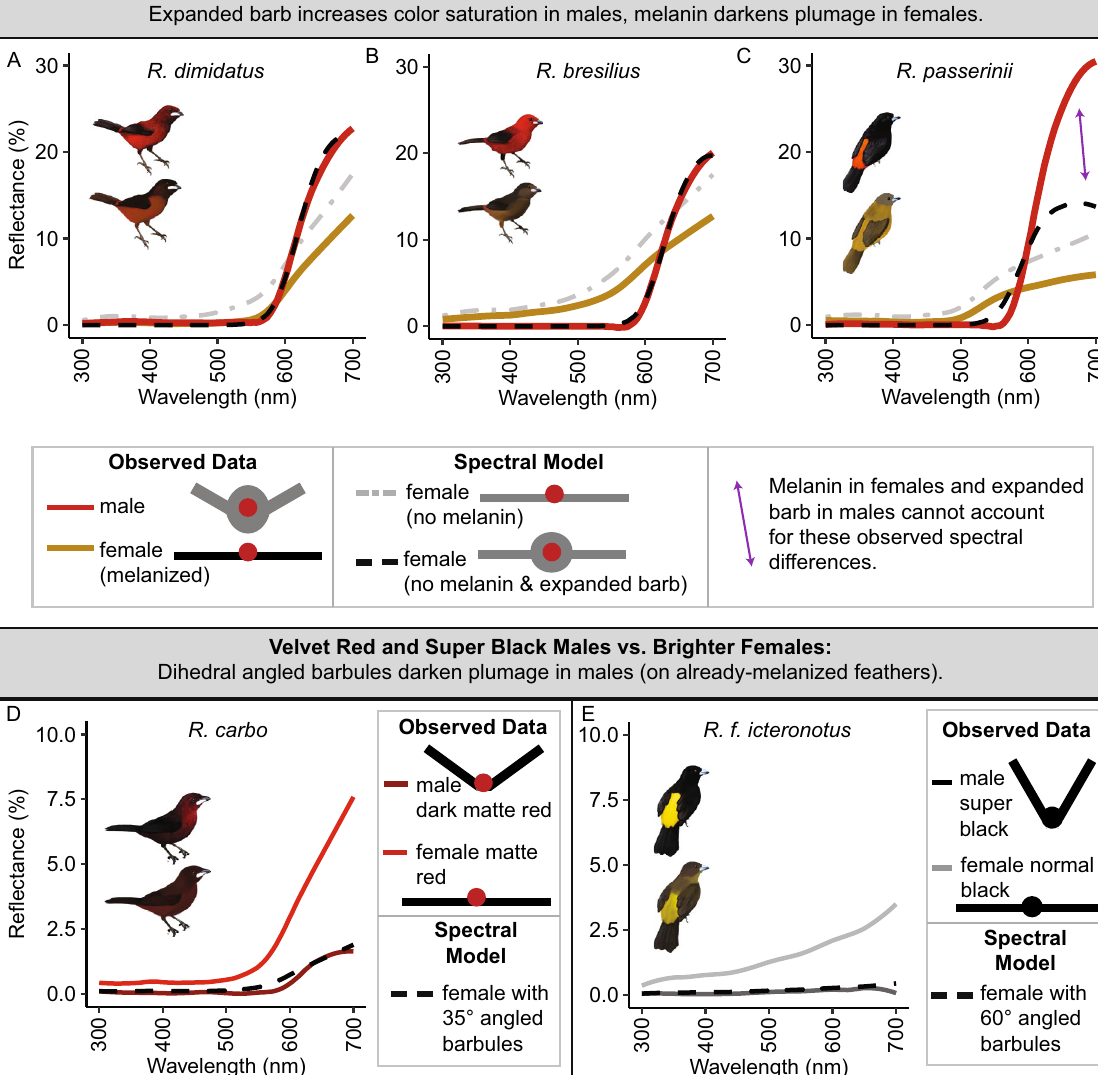
Figure 7. Curve-fitting with reflectance spectra suggests that male–female color differences are attributable to (i) melanin in females and (ii) microstructures in males. We manipulated real reflectance spectra of females to assess the role of melanin and microstructures in male–female differences (Supplementary Methods). We compared ( A – C ) colorful, saturated males to duller, browner female and ( D – E ) velvet red and super black males to relatively brighter females. ( A ) Reflectance spectra of a female R. dimidiatus rump (orange line), minus the effect of melanin (grey dashed line), and plus the predicted saturation increase due to an oblong expanded barb (dashed black line) matches well with observed reflectance spectra of a male R. dimidiatus rump (red line). Sigmoid curve parameters are a female = 0.02, a male = 0.06, b = 620, c = 22. ( B ) Reflectance spectra of a female R. bresilius rump (orange line), minus the effect of melanin (grey dashed line), and plus the predicted saturation increase due to an expanded barb (dashed black line) matches well with observed reflectance spectra of a male R. bresilius rump (red line). Parameters are a female = 0.02, a male = 0.06, b = 630, c = 20. ( C ) Reflectance spectra of a female R. passerinii rump (orange line), minus the effect of melanin (grey dashed line), and plus the predicted saturation increase of an expanded barb (dashed black line), is a poor match (purple arrow) for the observed reflectance spectra of a male R. passerinii rump (red line). Parameters are a female = 0.02, a male = 0.06, b = 590, c = 14. ( D ) Reflectance spectra of female R. carbo dark red breast (red line), divided by 4 to indicate structural contribution of dihedral barbules at a ~ 35° angle (dashed black line), matches well to observed reflectance spectra of R. carbo dark matte red breast (dark red line). ( E ) Reflectance spectra of female R. f. icteronotus black back (grey line), divided by 8 to indicate structural contribution of dihedral barbules at a ~ 60° angle (dashed black line), matches well to observed reflectance spectra of male R. f. icteronotus super black back (black line). Divisors for each barbule angle can be found in Fig. 6A. Artwork in male silhouettes credit Gabriel Ugueto; female silhouettes are modified by Allison Shultz from original art by Gabriel Ugueto. For information about melanin presence, see Supplementary